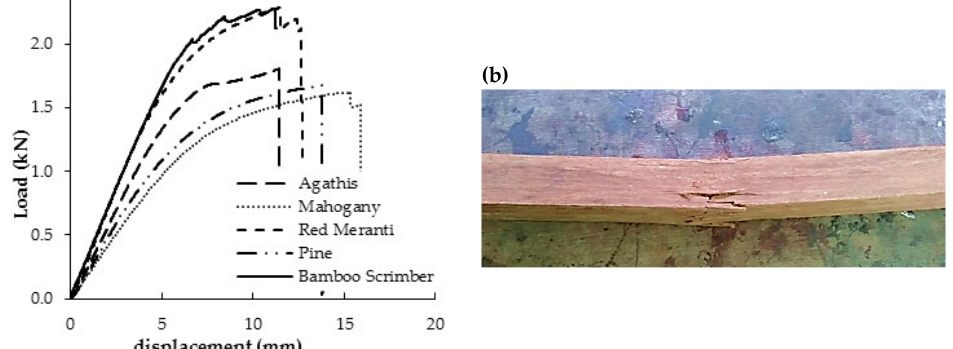
Figure 9. Flexural test ( a ) results and ( b ) specimen failures in bamboo scrimber.